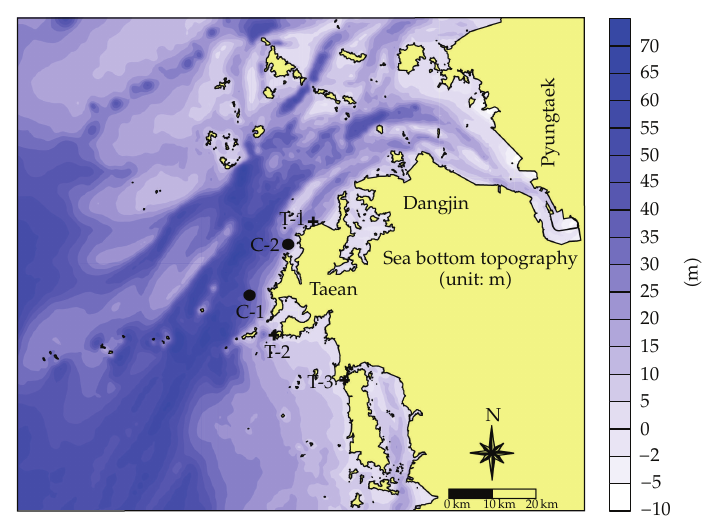
Figure 4: Computational domain and sea bottom